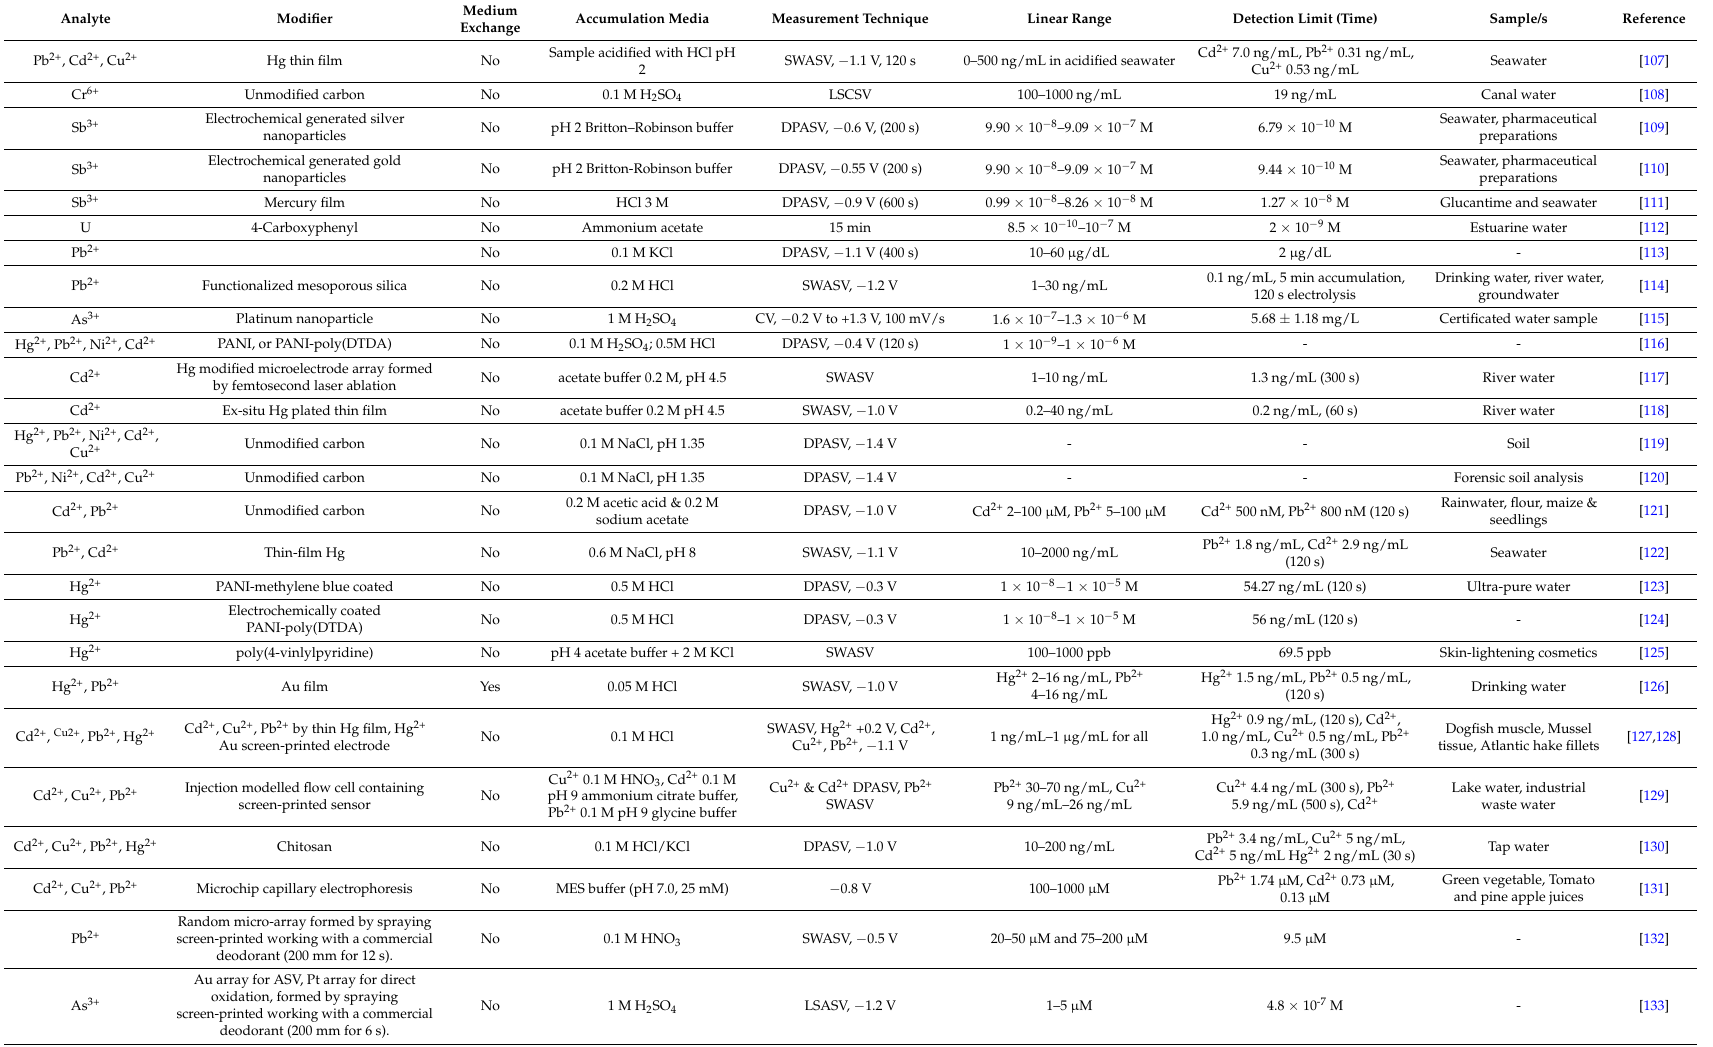
Table 8. Reports of screen-printed carbon electrodes for the determination of metal